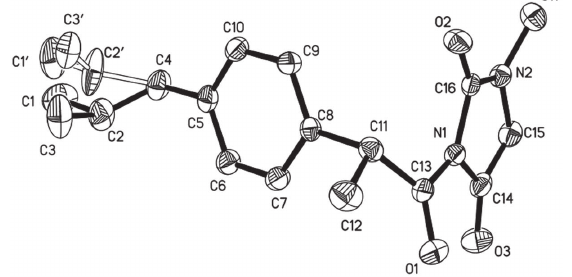
Table 1: Data collection and